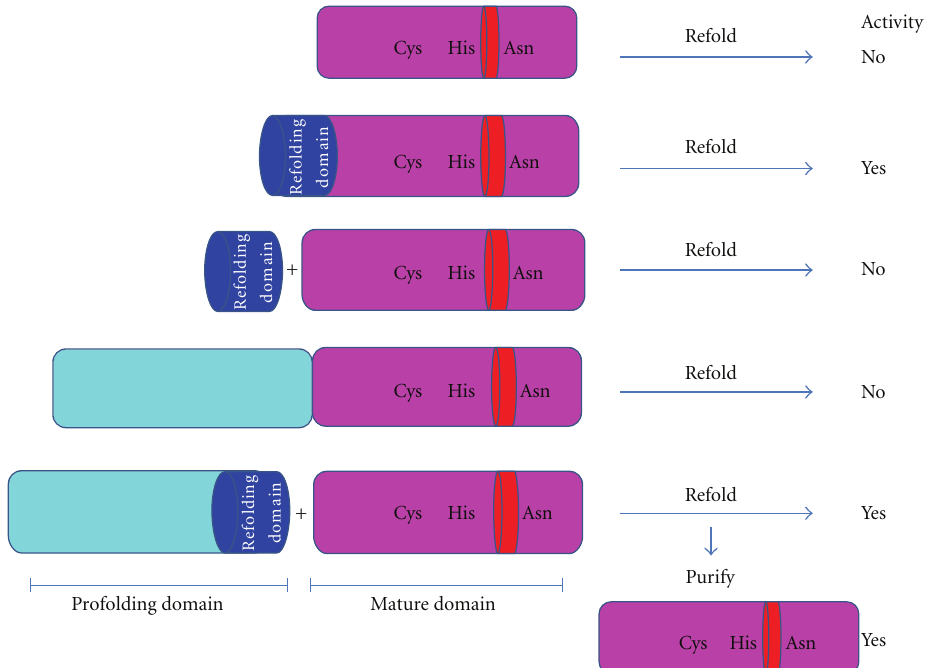
Figure 5: Expression and refolding of di ff erent constructs of falcipain-2. Di ff erent constructs were used to study refolding. The mature domain was expressed alone or with the refolding domain either in cis or trans. In the last construct, folding of mature domain was done in trans with profolding domain. After purification of the mature domain, the activity was assayed [29].